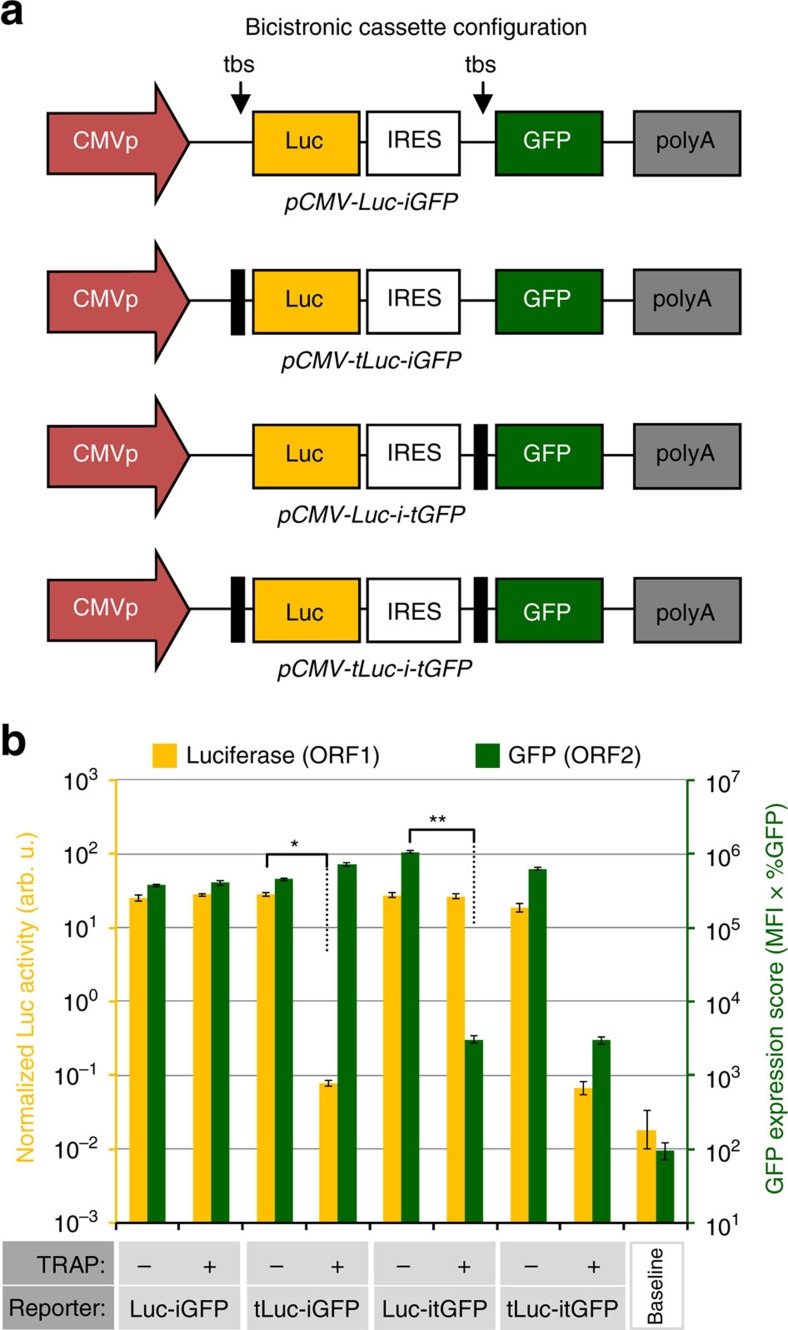
Repression of multicistronic transgene cassettes using the TRAP-tbs configuration.(a) Bicistronic reporter plasmids encoding Firefly luciferase (Luc; ORF1 position) and green fluorescent protein (GFP; ORF2 position); ORF2 being dependent on cap-independent translation. The constructs vary in position and number of tbs sequences controlling the ORFs. (b) HEK293T cells were transfected with the bicistronic plasmids±TRAP, and a Renilla Luciferase plasmid was co-transfected in all conditions to allow normalization of FireFly luciferase activity. Duplicate sets of cells were either analysed for normalized luciferase activity in cell lysates (left y-axis; yellow bars) or live cells analysed for GFP expression by flow cytometry (right axis; green bars). All data are mean average values±s.d. [log10-transformed data] (n=3); *P<1.5 × 10−7, **P<1.4 × 10−5 [Welch's t-test]. (CMVp, Cytomegalovirus promoter; tbs, TRAP-binding sequence; IRES, internal ribosomal entry site (encephalomyocarditis virus); polyA, polyadenylation signal). Results are representative of two independent experiments.